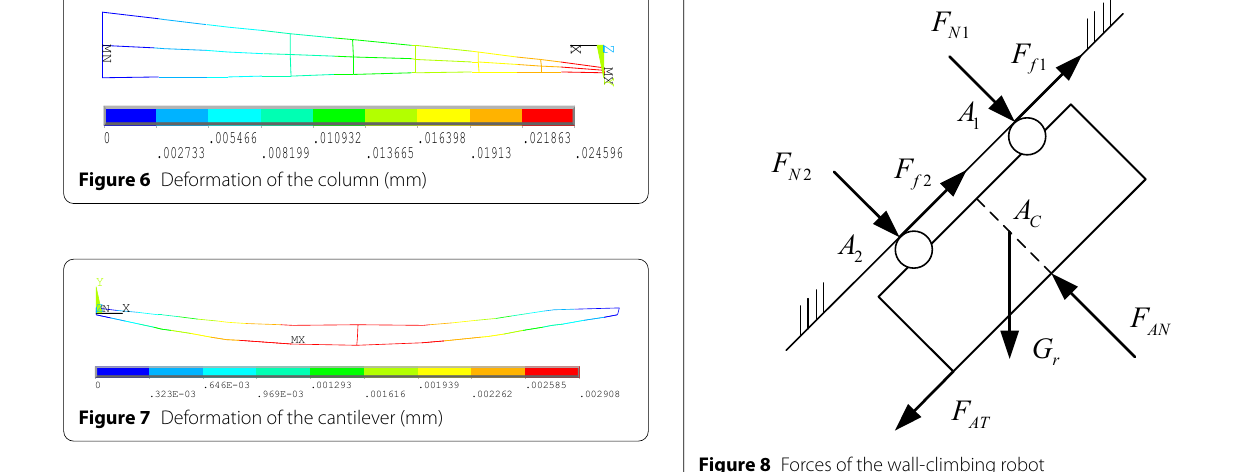
Figure 6 Deformation of the column (mm)